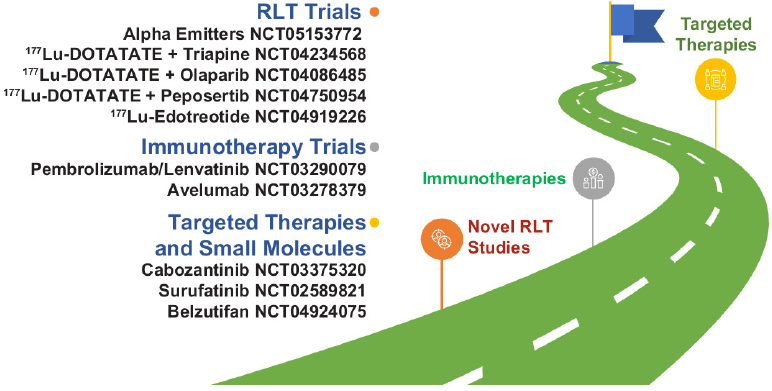
Figure 3. Novel therapy development in NETs as illustrated by select trials focusing on novel com- binations and new agents or classes of drugs. Most of the agents listed are not commercially availa- ble in the United States for NETs. 177 Lu, lutetium-177; NET, neuroendocrine tumor; RLT, radioligand therapy.